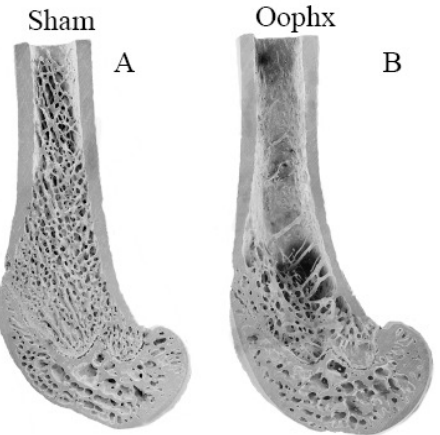
Figure 2. Scanning electron micrographs of distal femora from 11-month old Sprague-Dawley female rats fed 0.8% diet calcium at 150 days post-operation: ( A ) Ovary-intact, sham operation; ( B ) Oophorectomized. In the Diaphyseal and Metaphyseal region bone loss is evident following oophorectomy which is absent in the